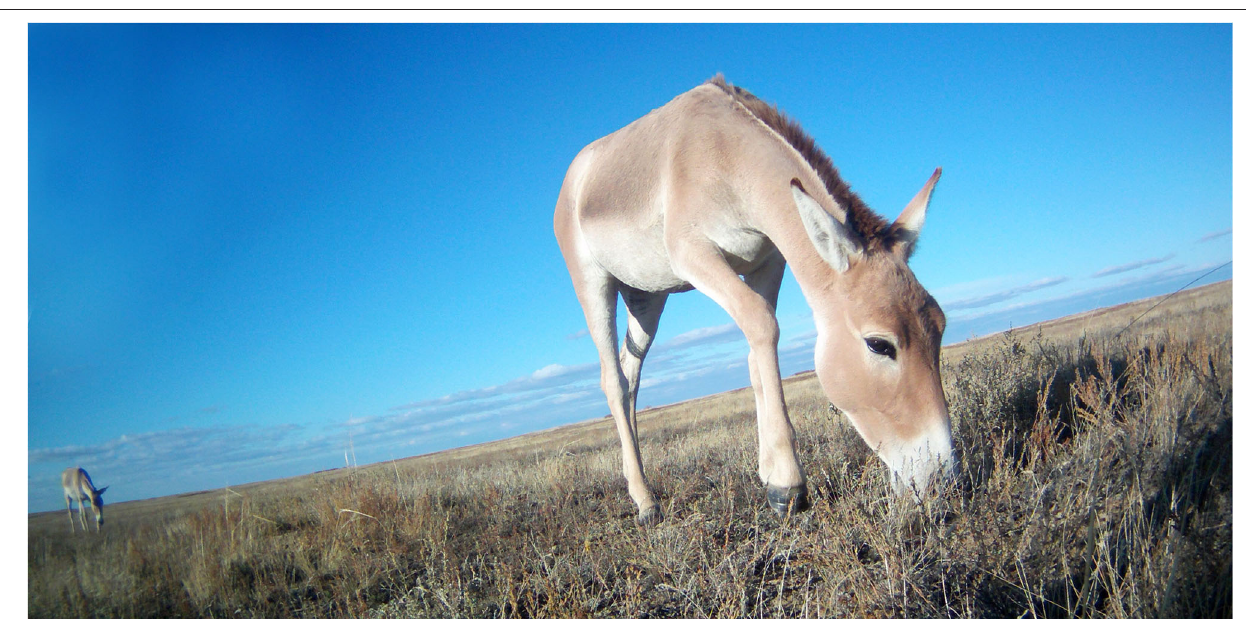
FIGURE 4 | Image from mare 26176’s camera collar showing two yearlings feeding in the Torgai region after release and after split-up from the other three GPS collared mares.